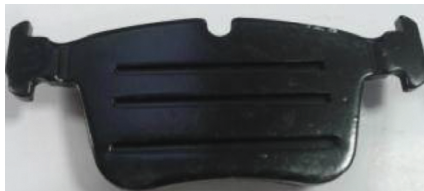
Table 8: Bench test of Sample 3.